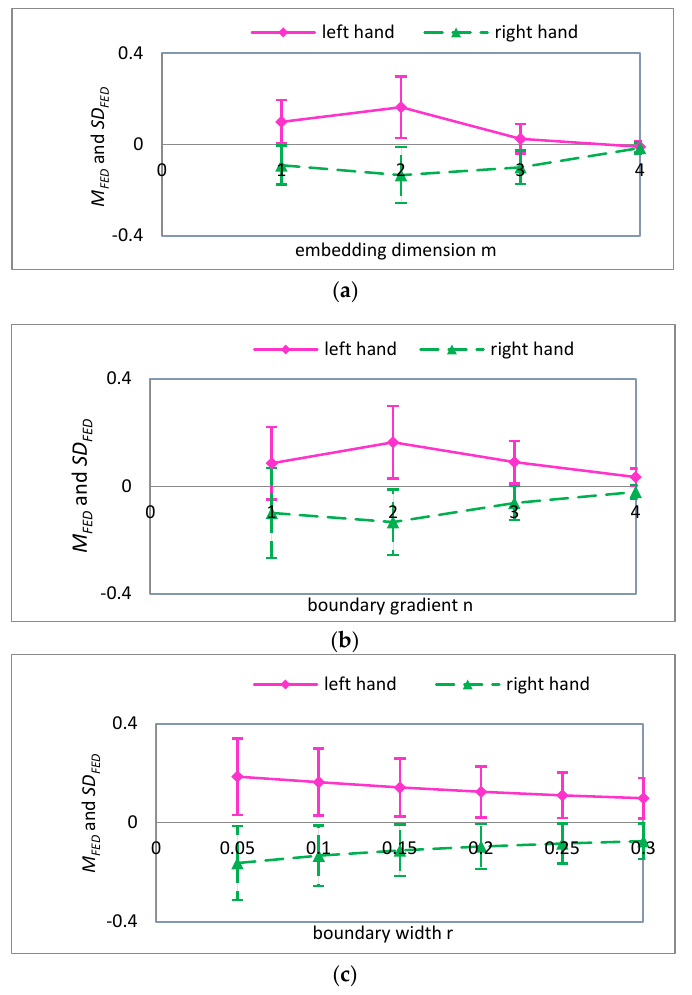
Figure 8. For =3 τ , the mean and standard deviation of FED curves for input variables ( a ) Figure 8. For τ = 3, the mean and standard deviation of FED curves for input variables ( a ) embedding embedding dimension m ; ( b ) boundary gradient n ; and ( c ) boundary width r . dimension m ; ( b ) boundary gradient n ; and ( c ) boundary width r